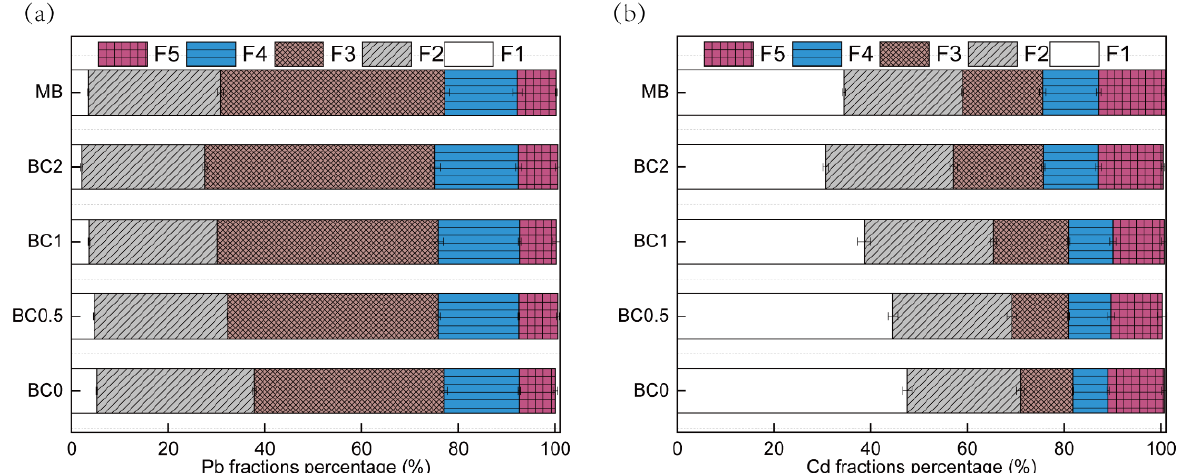
Figure 4. Percent Pb ( a ) and Cd ( b ) species distribution in soil. F1 means exchangeable fractions bound, F2 means carbonate fractions bound, F3 means Fe\Mn oxides fractions bound, F4 means organic fractions bound, and F5 means residual fractions bound. BC0, BC0.5, BC1 and BC2 mean as soil applied with T-BC of four rate (0, 0.5, 1 and 2% (w/w)); MB means as soil applied with 20 g/pot of biochar from mango leaves. BC0, BC0.5, BC1, and BC2 mean as soil applied with T-BC of four rate (0, 0.5, 1, and 2% (w/w)); MB means as soil applied with biochar (2% (w/w)) from mango leaves.